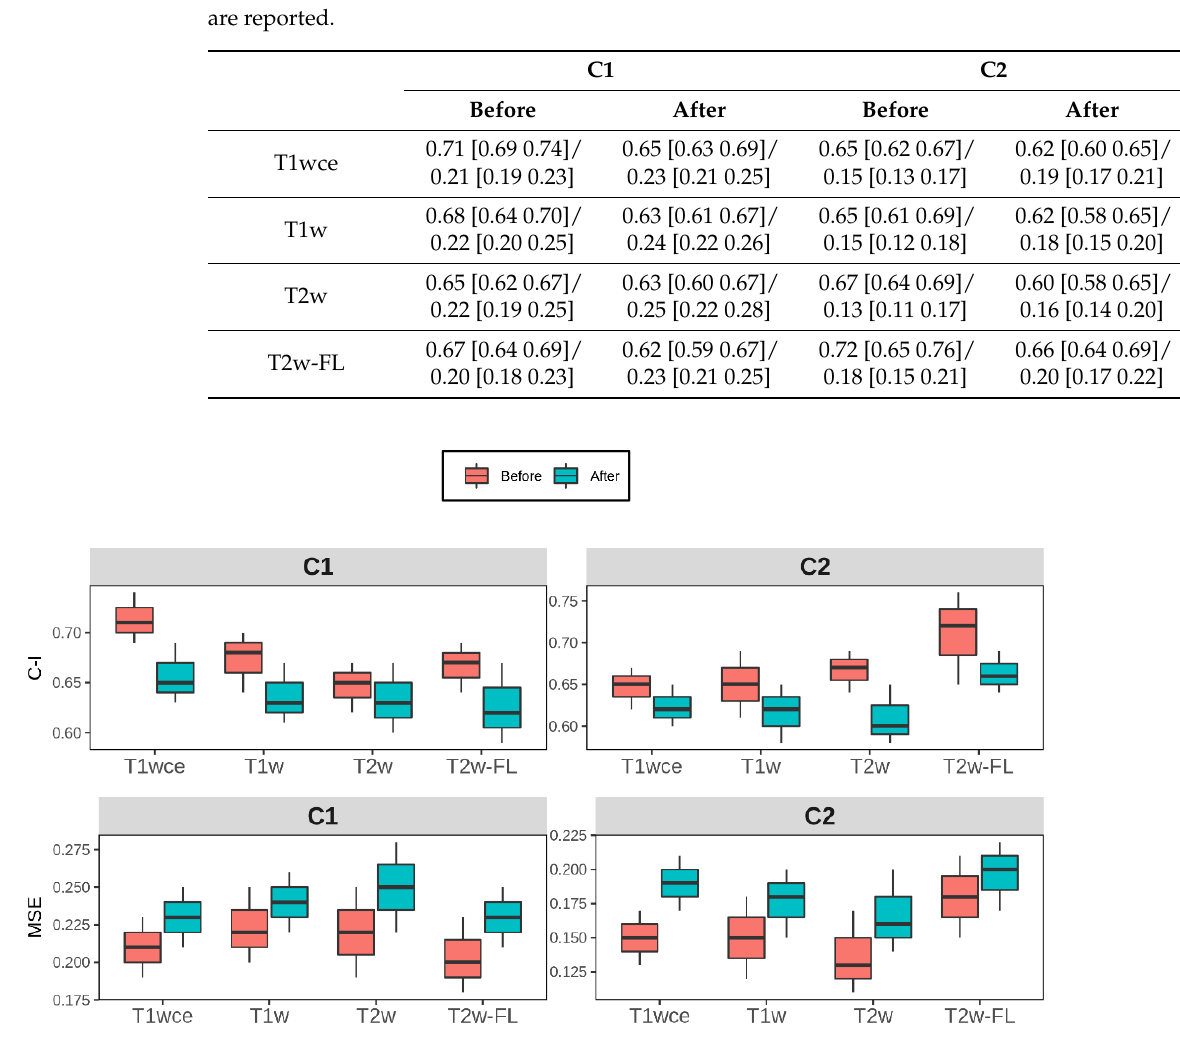
Figure 6. Box plots of the top-ranked image normalization method evaluation metrics C-I and MSE before and after the elimination of the intensity normalization impacted significant features for cohorts C1 and C2 for each MR sequence. The average (across all bin counts) 10-CV C-I/MSE with 95% confidence intervals are plotted. Performance of both models was similarly affected after the elimination of the intensity normalization impacted significant features, with a mean decrease in the 10-CV C-I and 10-CV MSE of 0.05 and 0.03 in all four sequences across both cohorts C-I: Concordance- index, mse: mean squared error, T2w-FL: T2w-FLAIR.